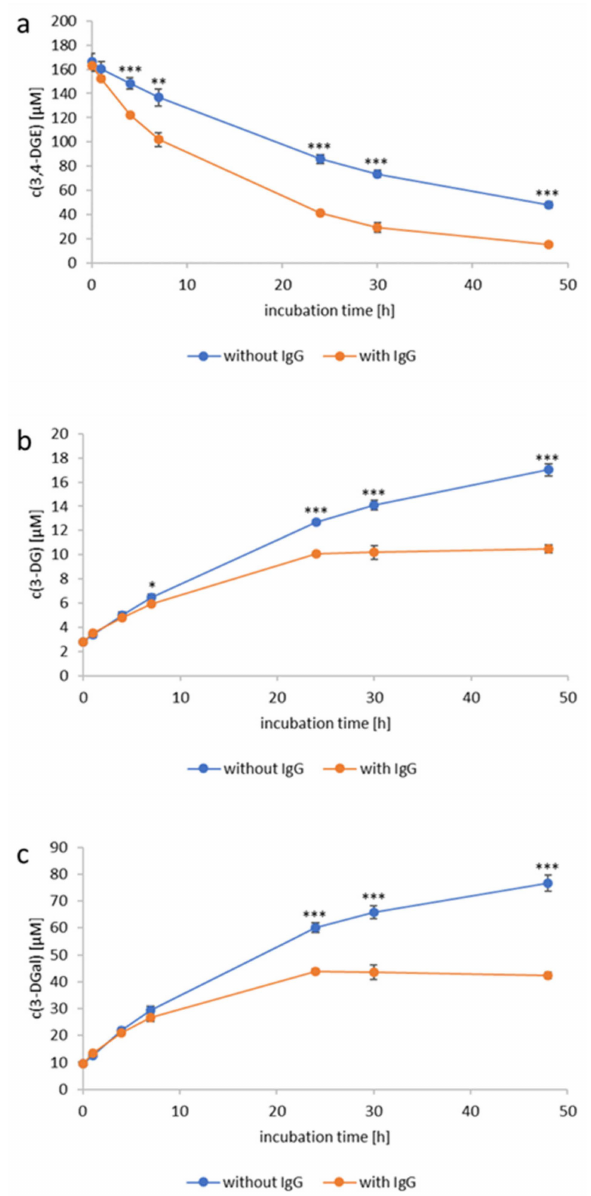
Figure 6. Human immunoglobulin G (IgG) partially depletes3,4-dideoxyglucosone-3-ene (3,4-DGE) from the model solution and, therefore, disables its interconversion to 3-deoxyglucosone (3-DG) and 3-deoxygalactosone (3-DGal). 3,4-DGE (166.2 µ M, containing 2.8 µ M 3-DG and 9.5 µ M 3-DGal) was incubated for 48 h at 37 ◦ C in the absence (blue curve) or presence (orange curve) of IgG (11.5 mg/mL). The time-course curves for the concentrations (in µ M, mean ± SD) of ( a ) 3,4-DGE, ( b ) 3-DG, and ( c ) 3-DGal are shown. All experiments were performed in triplicates. Significant differences between the samples with and without IgG are marked (* p < 0.05, ** p < 0.01, *** p <